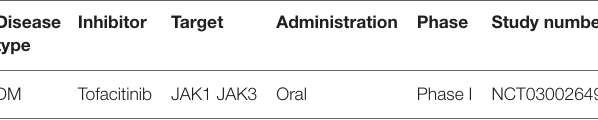
TABLE 4 | JAKi trial in patients with dermatomyositis. Disease